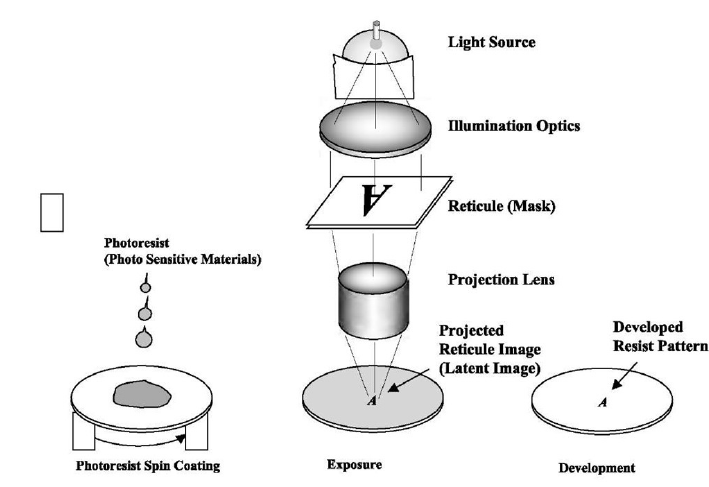
Figure 13. Schematic overview of optical projection lithography